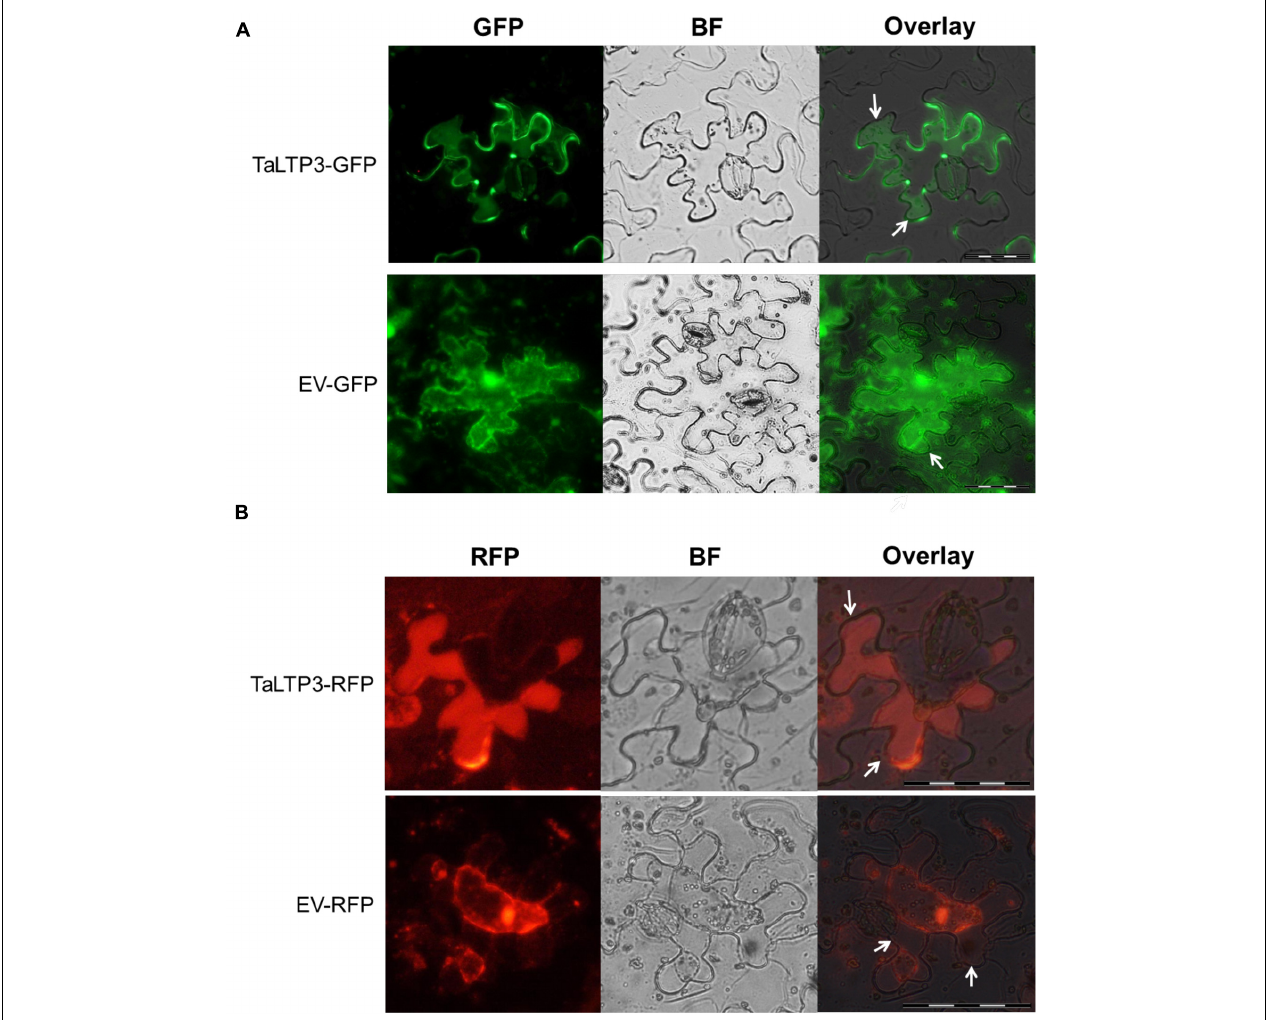
FIGURE 4 | TaLTP3 protein was localized in the apoplastic space. The TaLTP3-GFP (A) and TaLTP3-RFP (B) Recombinant proteins were transiently expressed in N. benthamiana leaves by agroinfiltration. GFP or RFP alone was used as a control. Leaf epidermal peels were plasmolyzed by incubation in 800 mM mannitol for 6 min. White arrows indicating the separation between the plant cell wall and plasma membrane during plasmolysis. Scale bar = 100 µ m. BF, bright field; EV, empty vector; GFP, green fluorescent protein; RFP, red fluorescent protein.